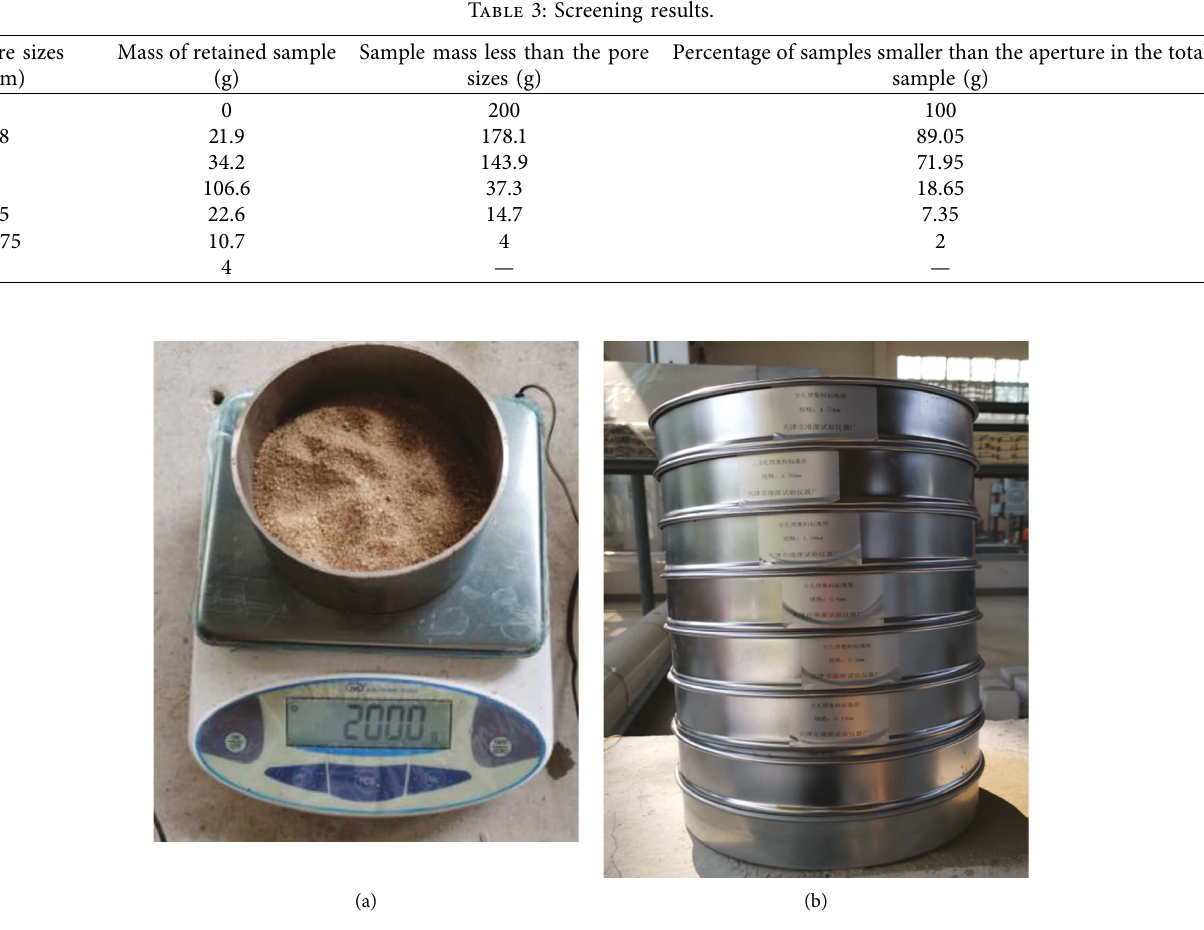
Figure 3: Tools for distribution of size. (a) Electronic scales. (b) Sieves of different pore sizes.